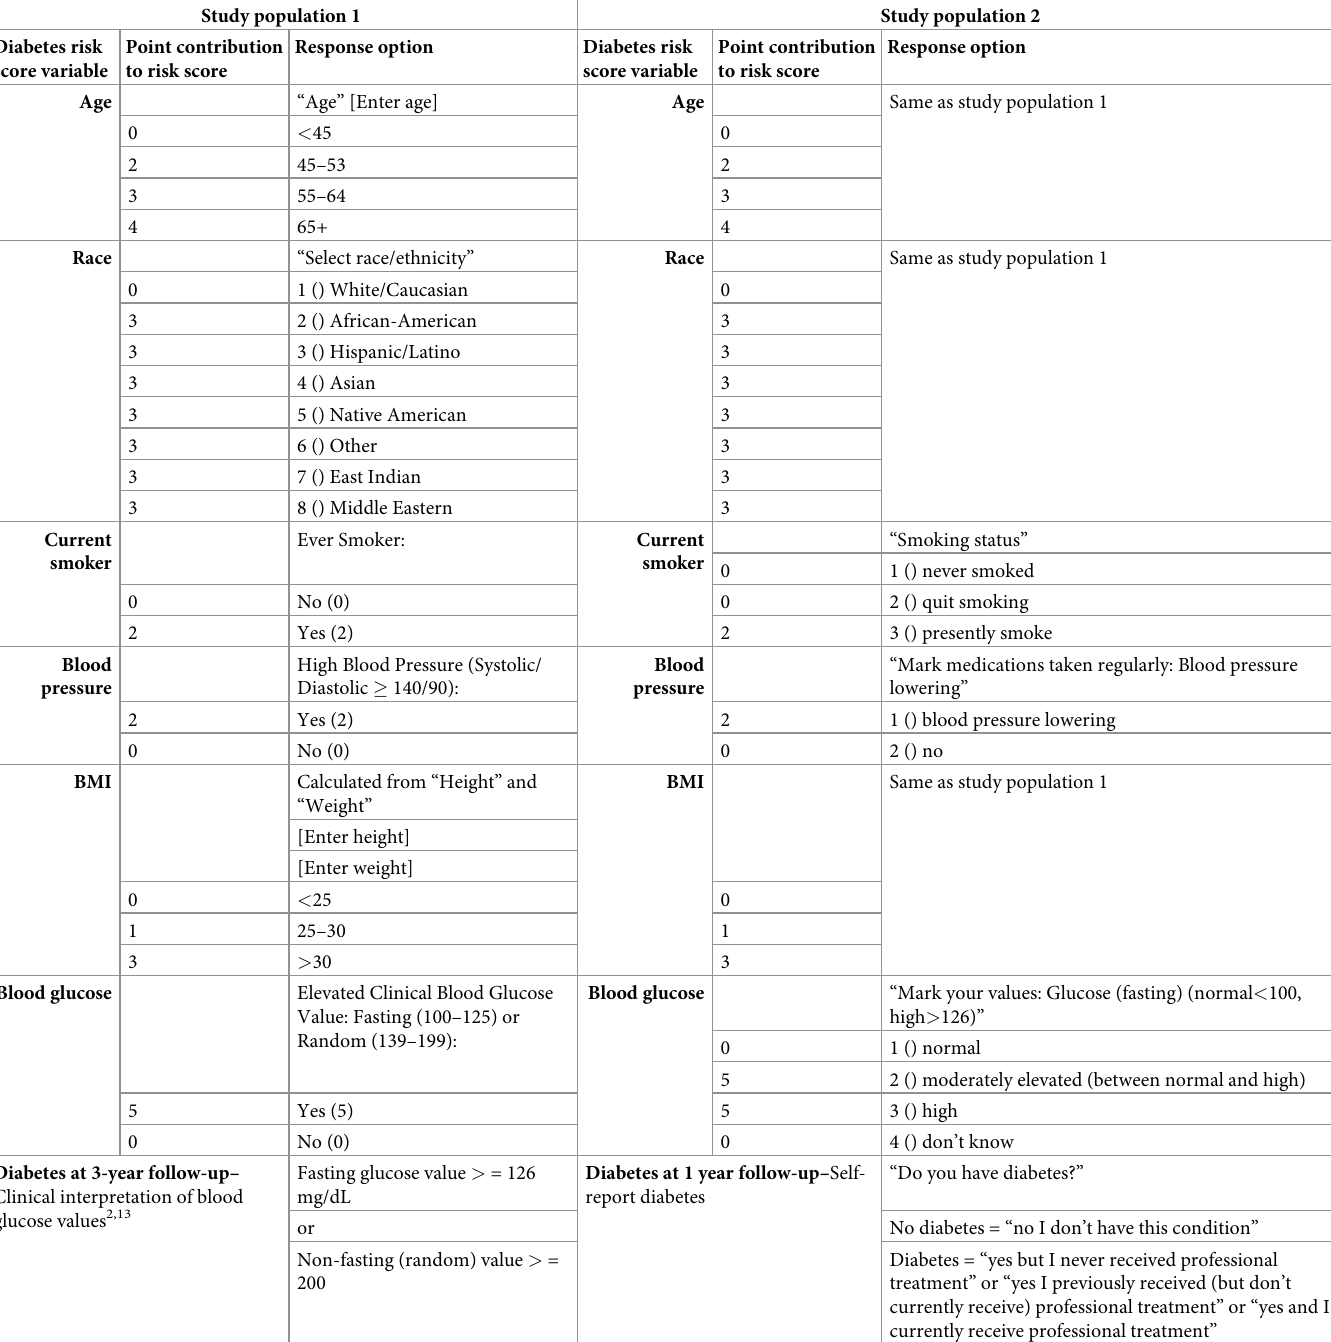
Table 1. Description of variables used in each study population to calculate the diabetes risk score and estimate diabetes at